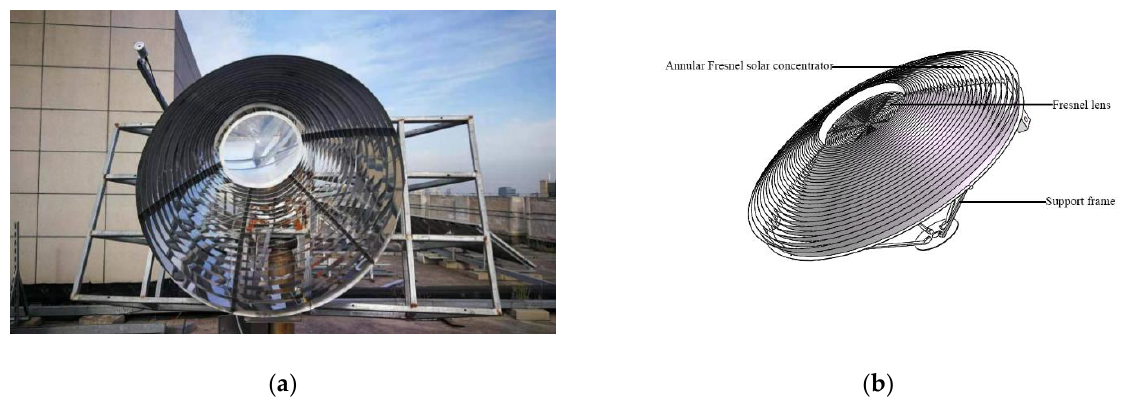
Figure 3. Details of AFSC ( a ) Structure of the annular Fresnel solar concentrator (AFSC) and ( b ) schematic diagram of the AFSC